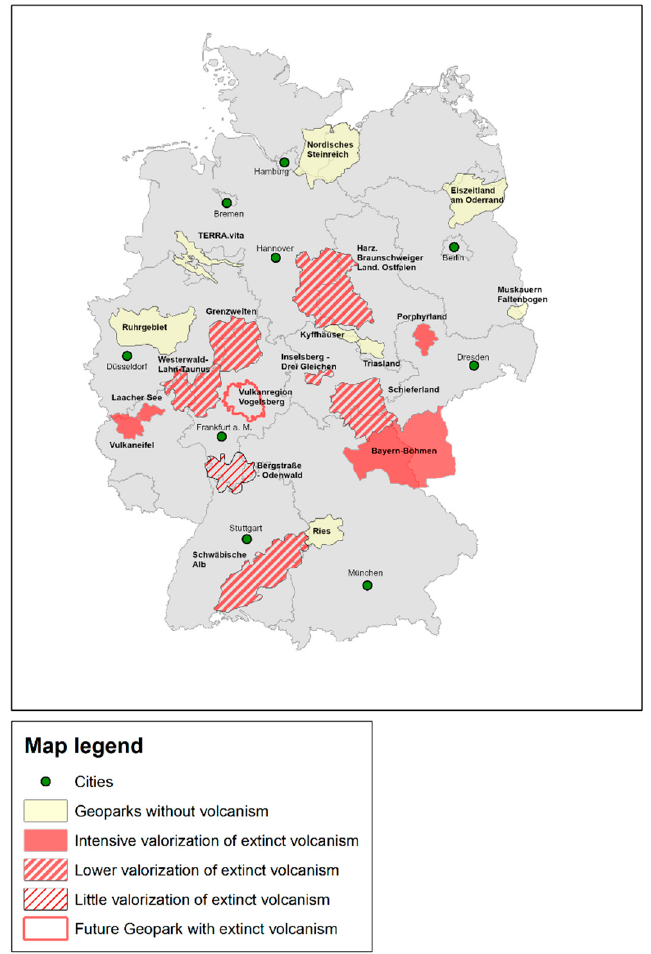
Figure 2. German Geoparks and the geotouristic valorization of extinct volcanism (Author’s design).